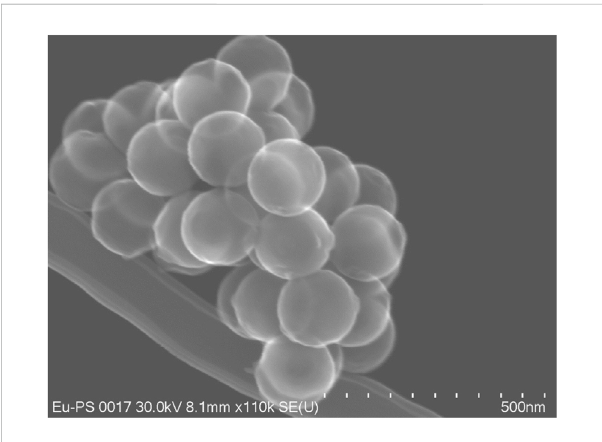
FIGURE 8 Core-shell beads with imbedded Eu(ttfa) 3 (TOPO) 2 with a carboxylate shell (core shell method 1); secondary emission image from a Hitachi 8230 Field Emission Gun Scanning Electron Microscope, 30